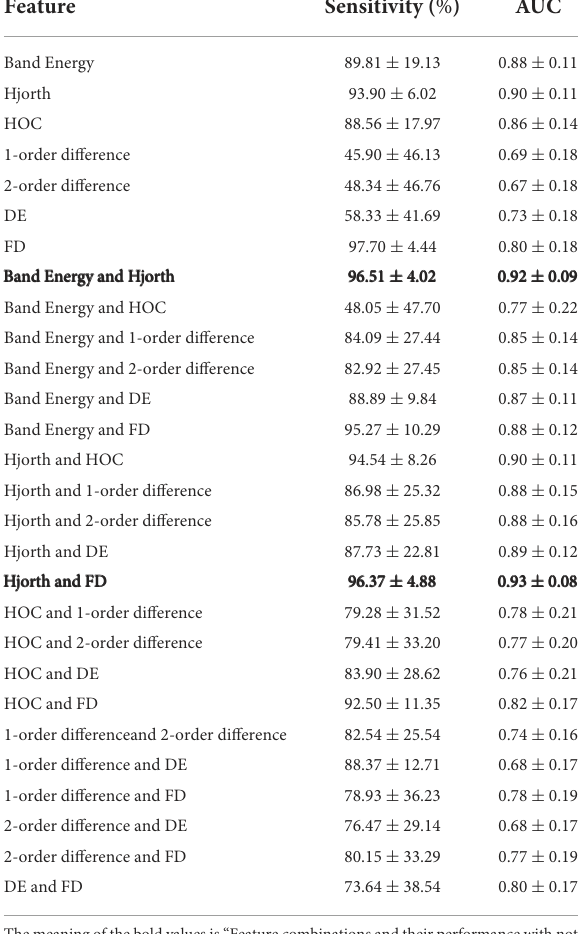
TABLE 2 Seizure prediction results of GCN for Band Energy and